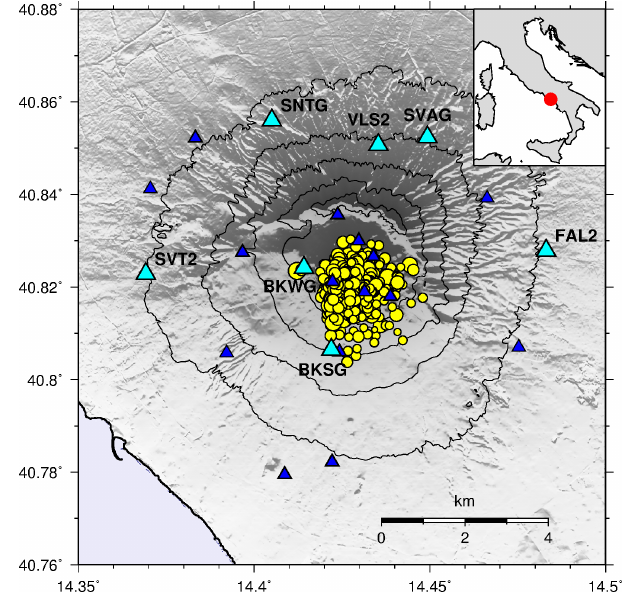
Figure 1. The monitoring seismic network operating on Mt. Vesu- vius during 2018. The cyan triangles indicate the position of stand- alone seismic stations used in this work while blue symbols show the position of permanent network stations. The yellow circles are the epicenters of the volcano-tectonic events occurred in 2018, with size proportional to magnitude. The position of Mt. Vesuvius in Italy is shown in the inset map.